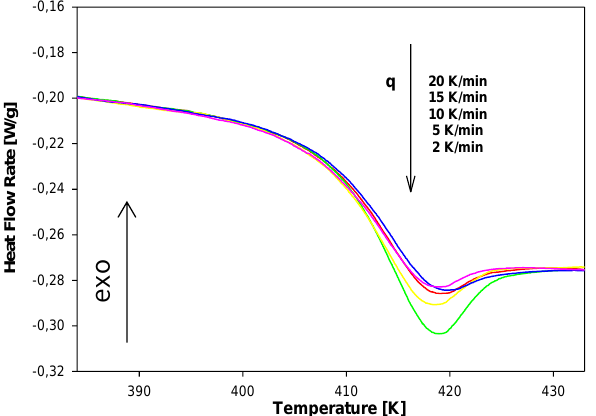
Figure 14. The dependence of heat flow rate on temperature obtained after the non-isothermal aging of PNIPA with a different cooling rate in the range of 2 K/min to 20 K/min.